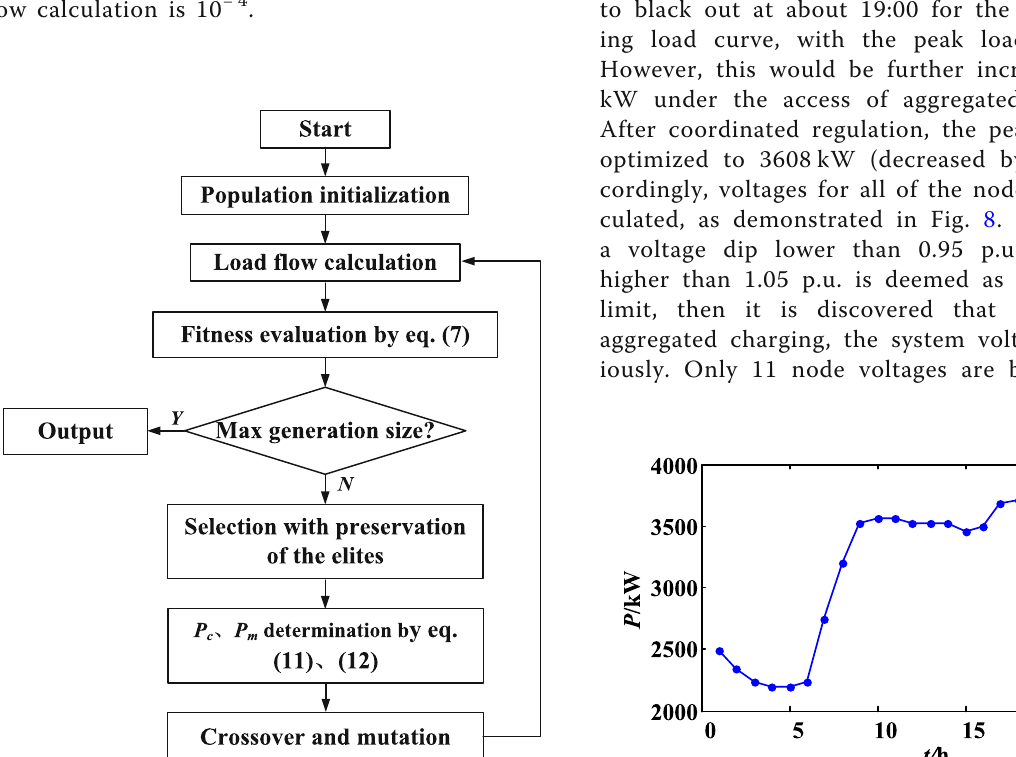
Fig. 4 Flowchart of the developed genetic algorithm